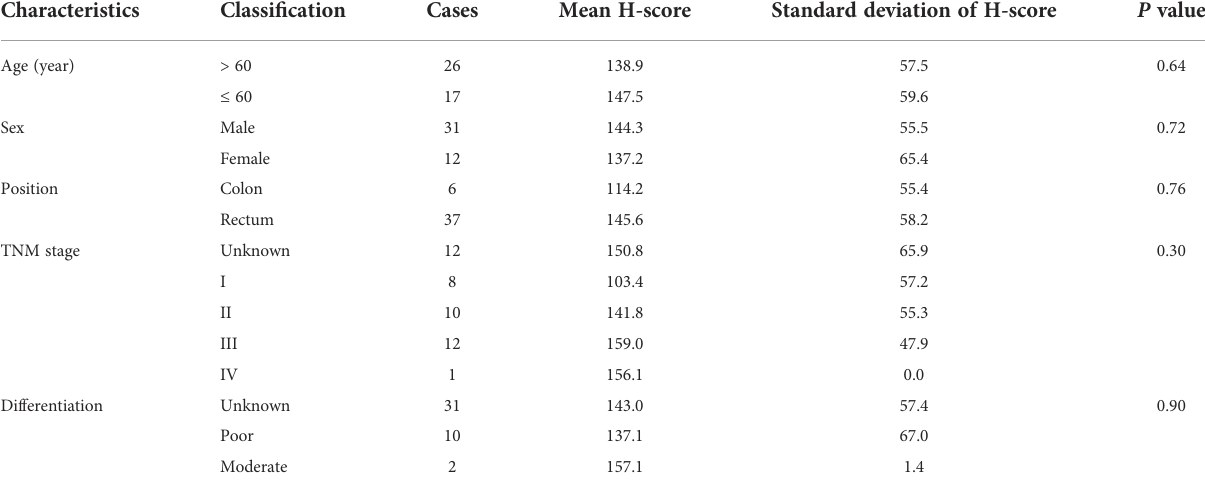
TABLE 2 ESM1 expression characteristics in CRC patients.